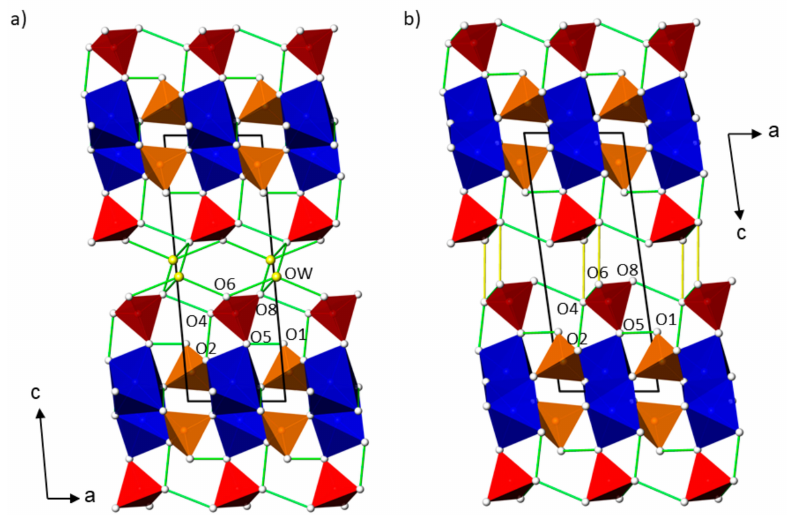
Figure 3. ( a )PossiblehydrogenbondingschemesinthecrystalstructuresofMn(HAsO 4 )(H 3 AsO 4 )(H 2 O) 0.5 ((a); projection along [010]) and Zn(HAsO 4 )(H 3 AsO 4 ) (( b ); projection along [010]). Hydrogen bonds with D ··· A contacts < 3.0 Å are given as green lines, and those > 3.0 Å as yellow lines. Color code as in Figure